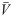
Effects of node length of stay on strain diversity.(A) Average richness and (B) Average Berger-Parker index for simulations on HOM model. Contour plots are shown in both figures. While exploring τ we also set the value of the average network size V¯ to 306, thus the injection rate can be computed by the relation λin=V¯/τ. For each value of β we highlight in panel (A) the value of the length of stay corresponding to the maximum richness (white asterisks) together with the analytical prediction (white line) obtained by using Eq (1). Here μ = 0.00192, k¯=0.89, aH = 0.28.